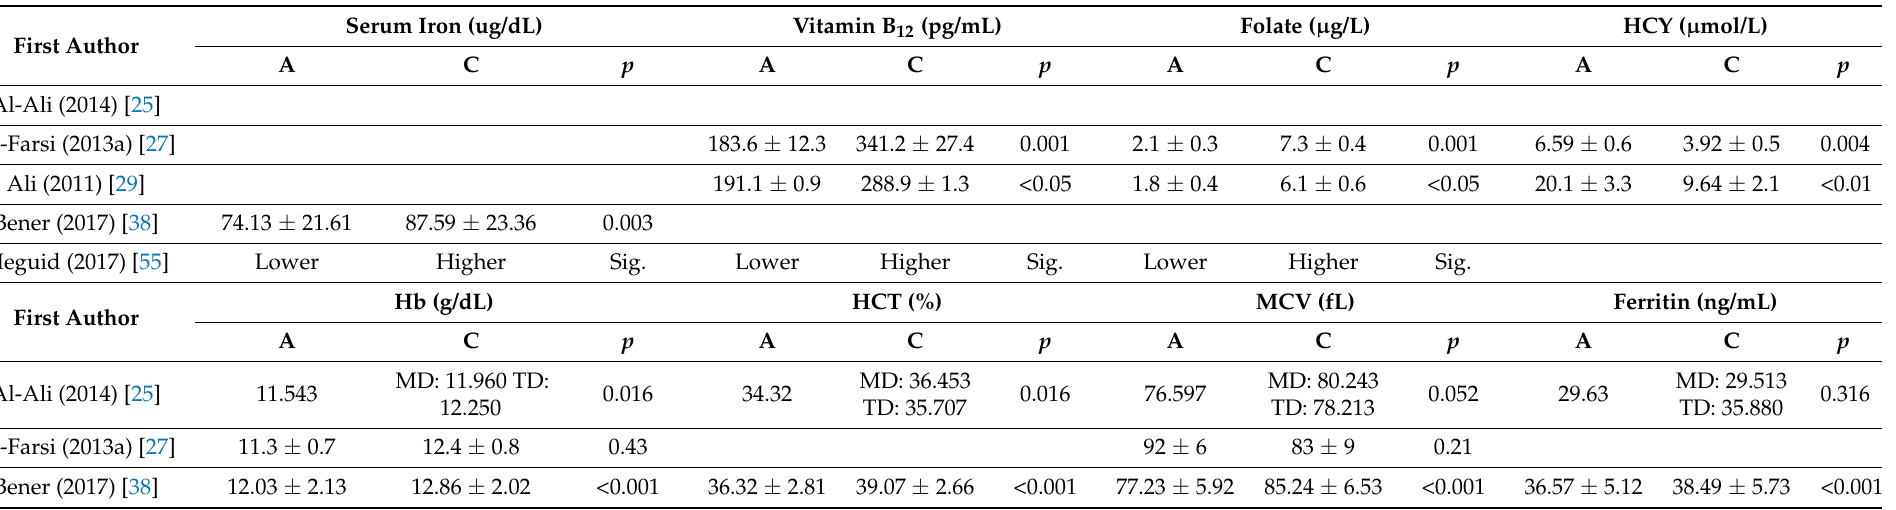
Table 4. Hematological biomarkers, iron status, vitamin B 12 , folate, and homocysteine data of children with autism spectrum disorder and controls in the MENA